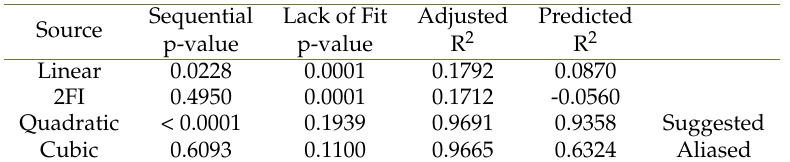
Table 3. Fit summary